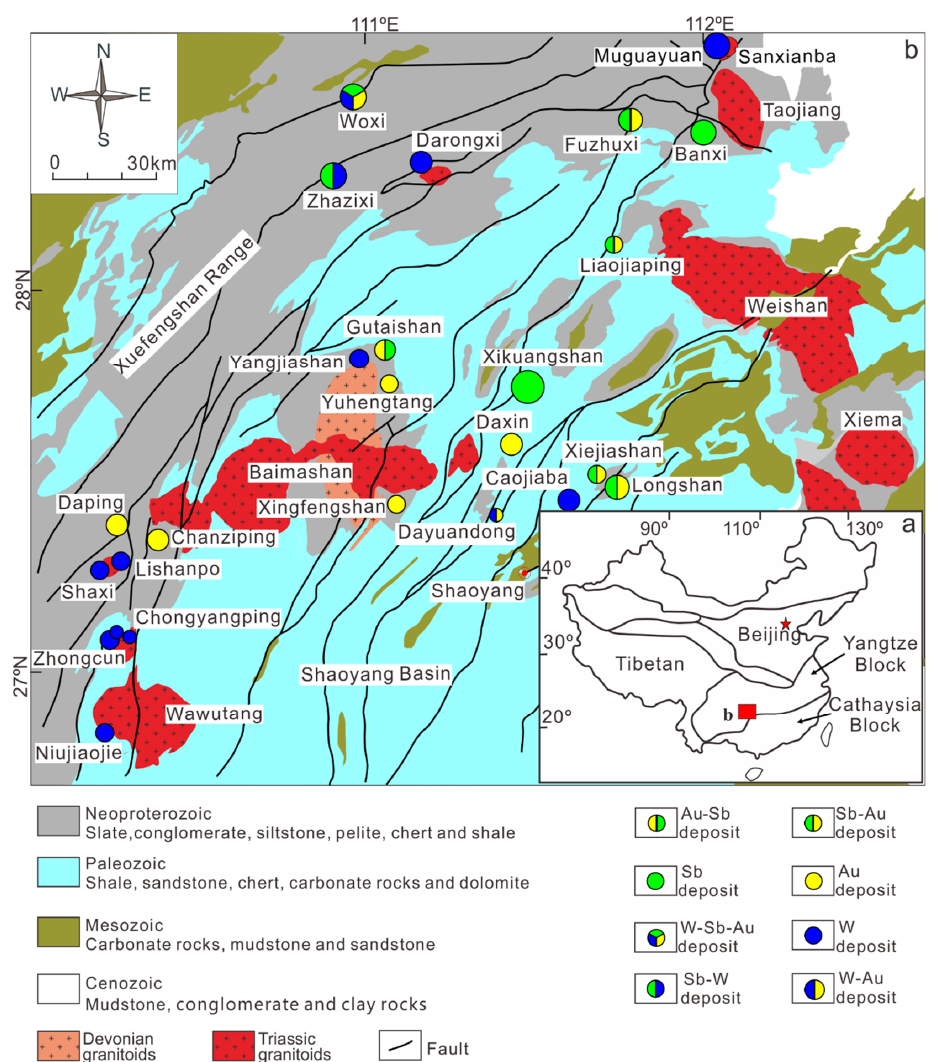
Figure 1. ( a ) Tectonic framework of China including the location of the XZMP. ( b ) Regional geological map of the XZMP in Central Hunan, South China, showing the distribution of granitic intrusions and important Sb, Au and W deposits (modified after Geological Map of the Hunan Province, the People’s Republic of China [32]; Chu et al. [33]).